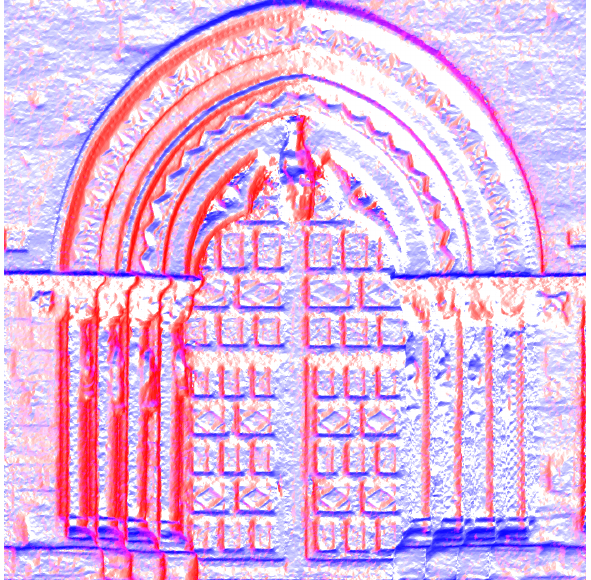
Figure 6: Normal map of the reconstructed model obtained by Photogrammetric triangulation. It was later refined at render time by small corrections acquired by Photometric Stereo methods. Red/blue colours code horizontal/vertical normal